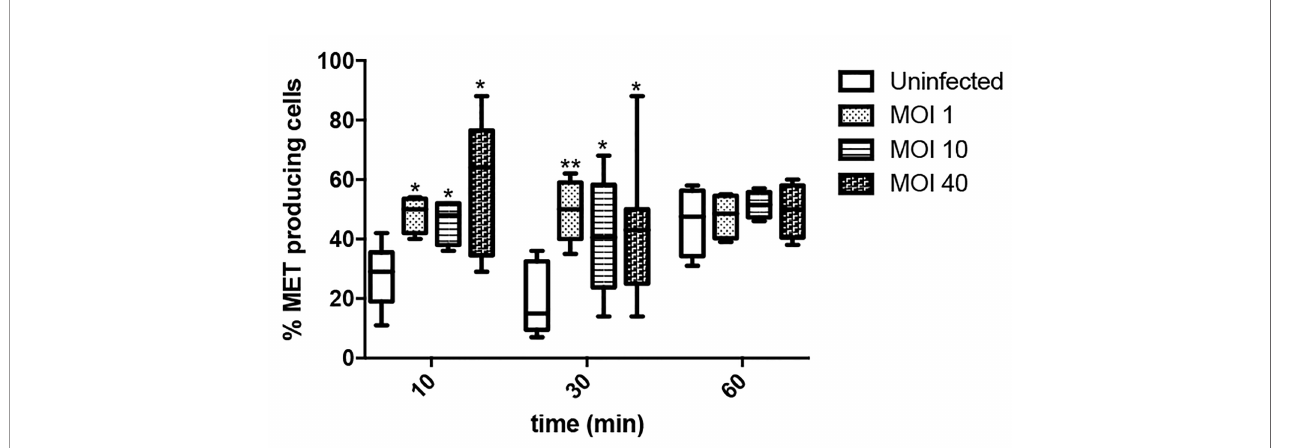
FIGURE 5 | Percentage of ET releasing macrophages after Salmonella infection. Cells were infected for 10, 30 or 60 minutes with Salmonella , MOI 1, 10 or 40. Number of selected fi elds was established so as to allow counting a minimum of 150 cells in each condition. Results are shown as mean ± SEM for each evaluated condition. * indicates signi fi cant differences between infected and uninfected cells in the same timepoint, *p ≤ 0.05, **p ≤ 0.01, Student T-test. One representative experiment of 2 independent ones